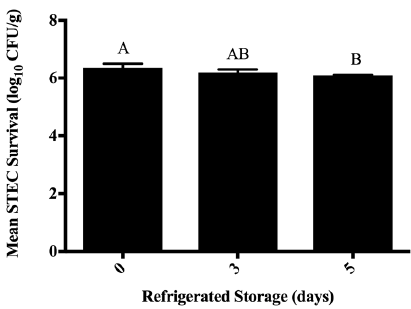
Figure 1. Survival of Shiga toxin-producing Escherichia coli (STEC) on ground beef during aerobic refrigerated storage ( p = 0.014; pooled SE = 0.083). Bars depict means of the main effect of storage period calculated from triplicate identical replicates ( n = 3); error bars depict one standard deviation from the mean. Columns not sharing letters (A,B) differ at p < 0.05. Beef trimmings were ground through a 3/8 inch plate following antimicrobial intervention, separated into 10.0 g samples, and stored for up to five days at 5 ± 1 °C prior to STEC enumeration on Petri dishes containing tryptic soy agar supplemented with 100.0 μ g/mL of rifampicin.